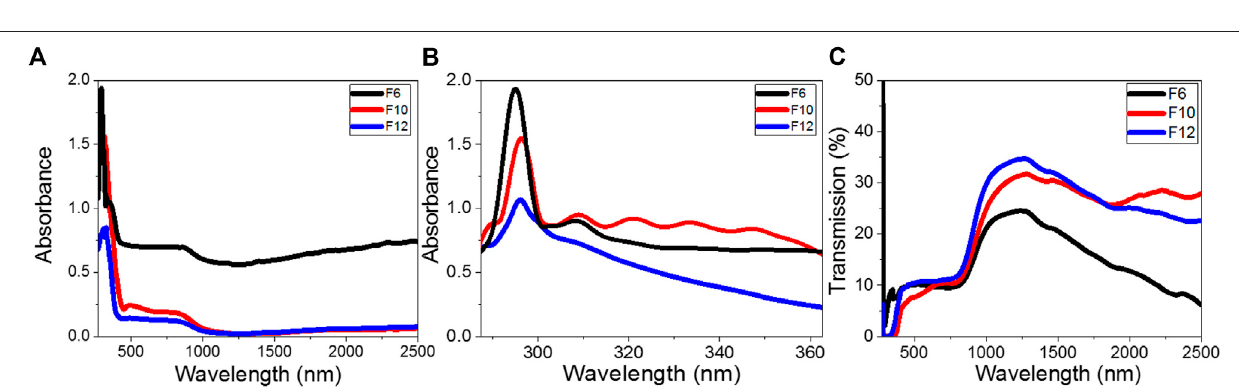
Frontiers in Chemistry |